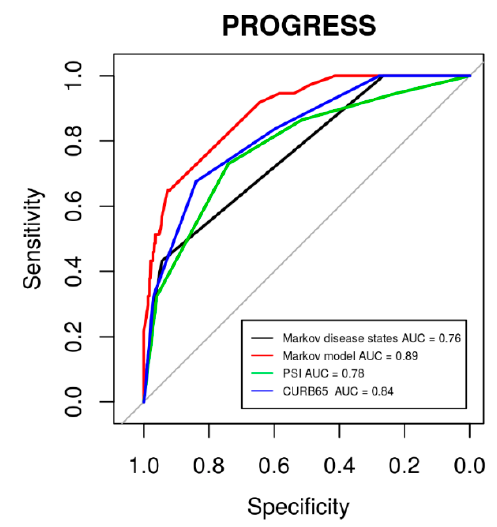
Figure 9. ROC curves for 28 d mortality in the PROGRESS data using established scoring systems PSI (area under curve (AUC) = 0.78, 95% CI: 0.71 – 0.86) and CURB-65 (AUC = 0.84, 95% CI: 0.76 – 0.89) in comparison to our initial disease states (AUC = 0.76, 95% CI: 0.70 – 0.83) and our model-based risk assessment (AUC = 0.89, 95% CI 0.84 – 0.94).